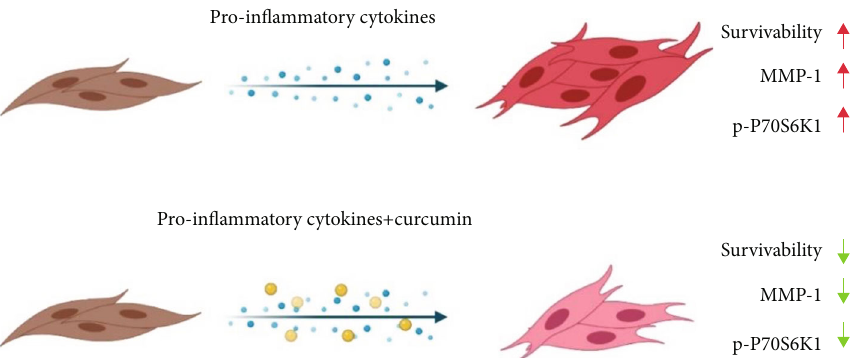
Figure 9: Graphical abstract presenting the curcumin e ff ect of the in fl ammatory marker reduction in the proposed rheumatoid arthritis in vitro